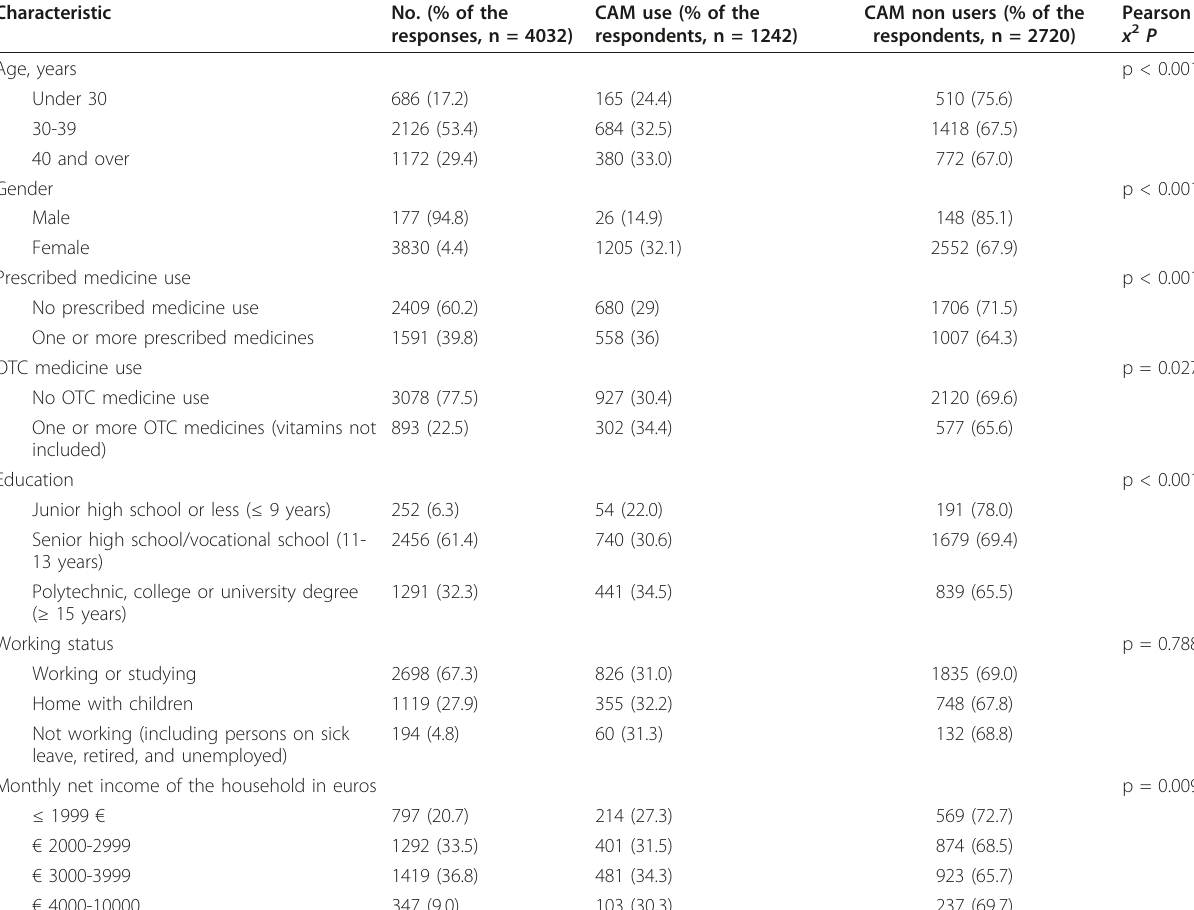
Table 1 Characteristics of the study population and CAM use by these characteristics of the respondents